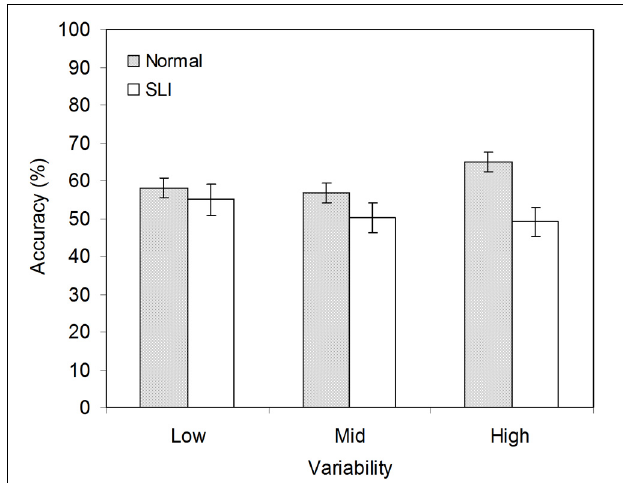
FIGURE 1 | Mean accuracy for the NL and the SLI group in the low, mid, and high variability conditions. Error bars represent s.e.m.